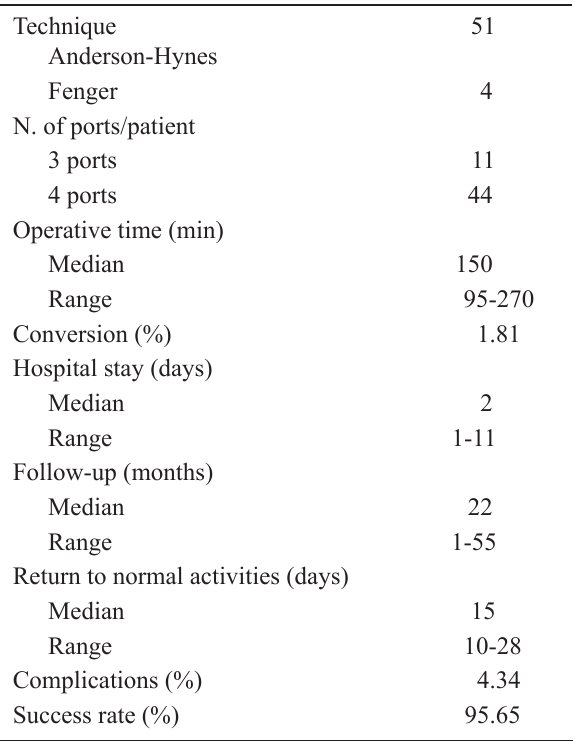
Table 2 – Summary of